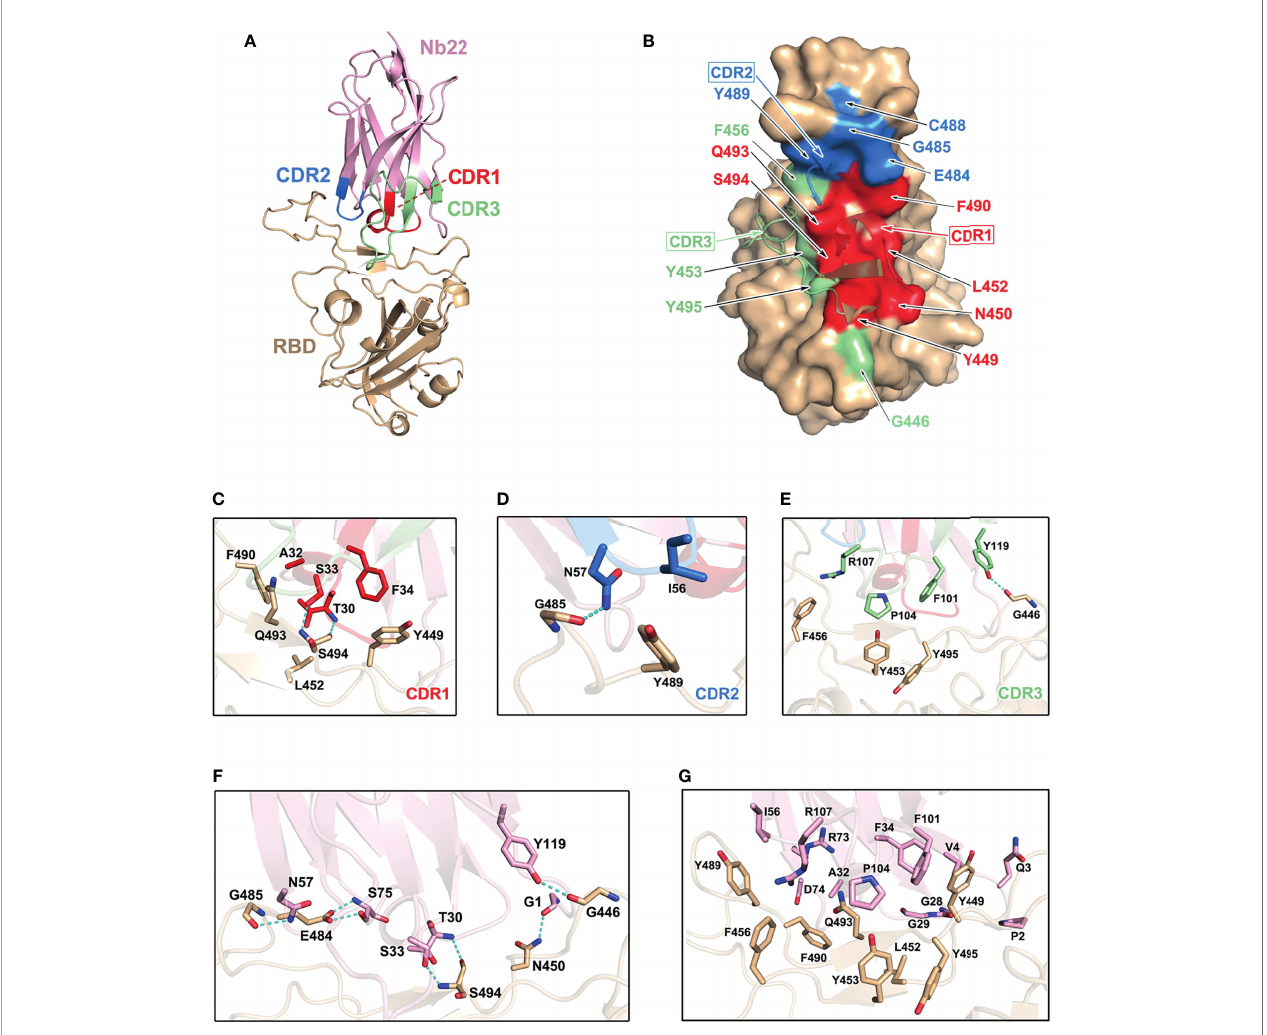
FIGURE 3 | Structural analysis of Nb22 and WH01 RBD complex. (A) The overall complex structure of Nb22 and WH01 RBD. The CDR1 (red), CDR2 (blue), CDR3 (green) of Nb22 (pink), and WH01 RBD (orange) are displayed in cartoon representation. (B) The epitope of Nb22 shown in surface representation. The CDR regions are colored in red, blue, and green, respectively. The interaction between CDR1 (C) , CDR2 (D) , CDR3 (E) , and WH01 RBD (F) . The hydrogen bonds of the interface between Nb22 and WH01 RBD. The hydrogen bonds are shown in cyan dash line. (G) The hydrophobic network between Nb22 and WH01 RBD. All the residues are shown in